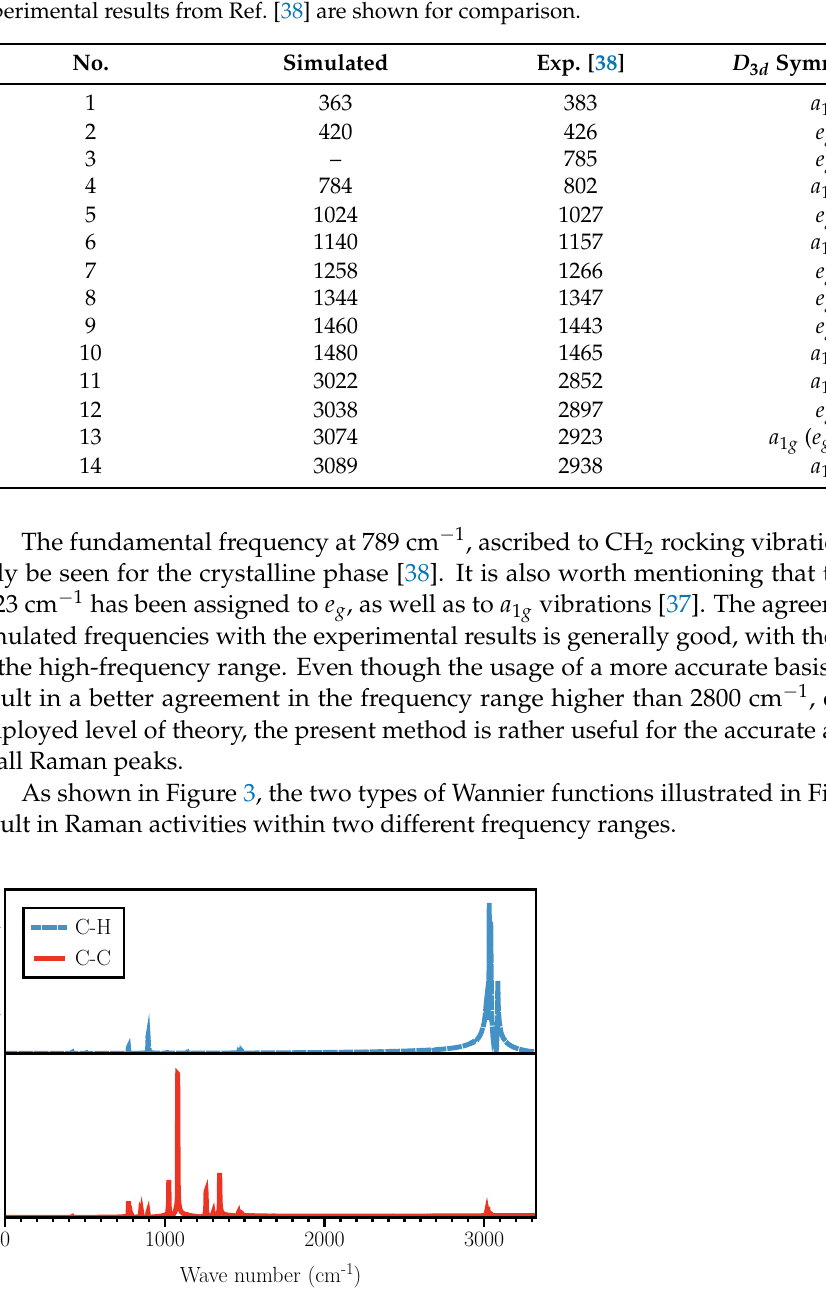
Figure 3. Simulated partial Raman spectra using Wannier functions along C–H (blue dashed) and C–C (red solid) bonds. Only the results obtained using just one Wannier function are shown for each type of